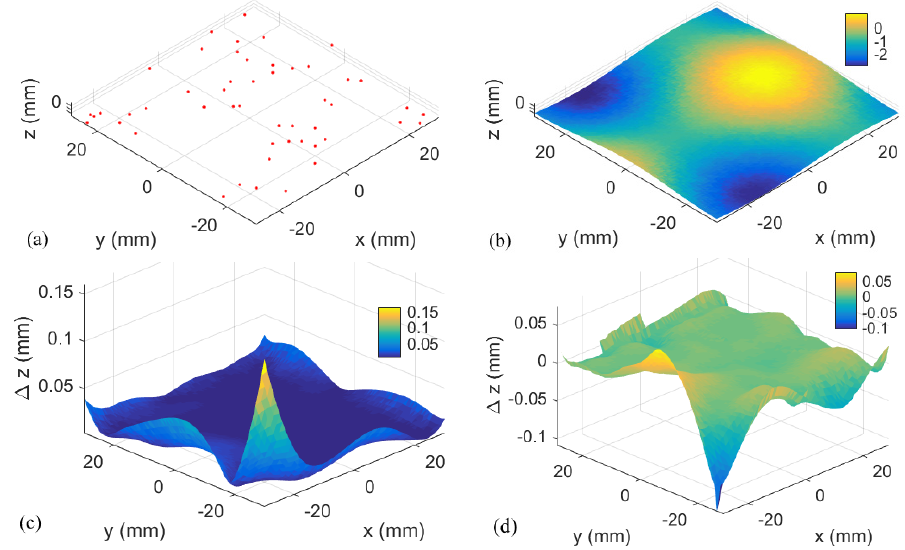
Figure 20. Measurement data and Gaussian process result: ( a ) raw data of measurement with the touch trigger probe; ( b ) mean surface; ( c ) associated uncertainty for laser sensor; and ( d ) deviation of the mean surface from the reference data.